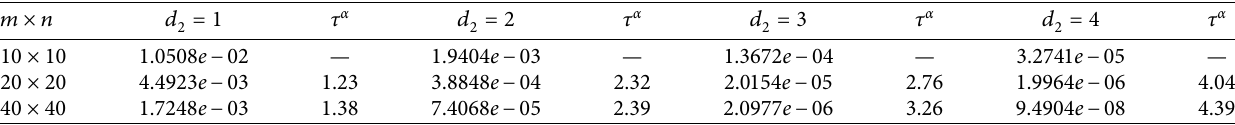
� 9 for Example 3. 1